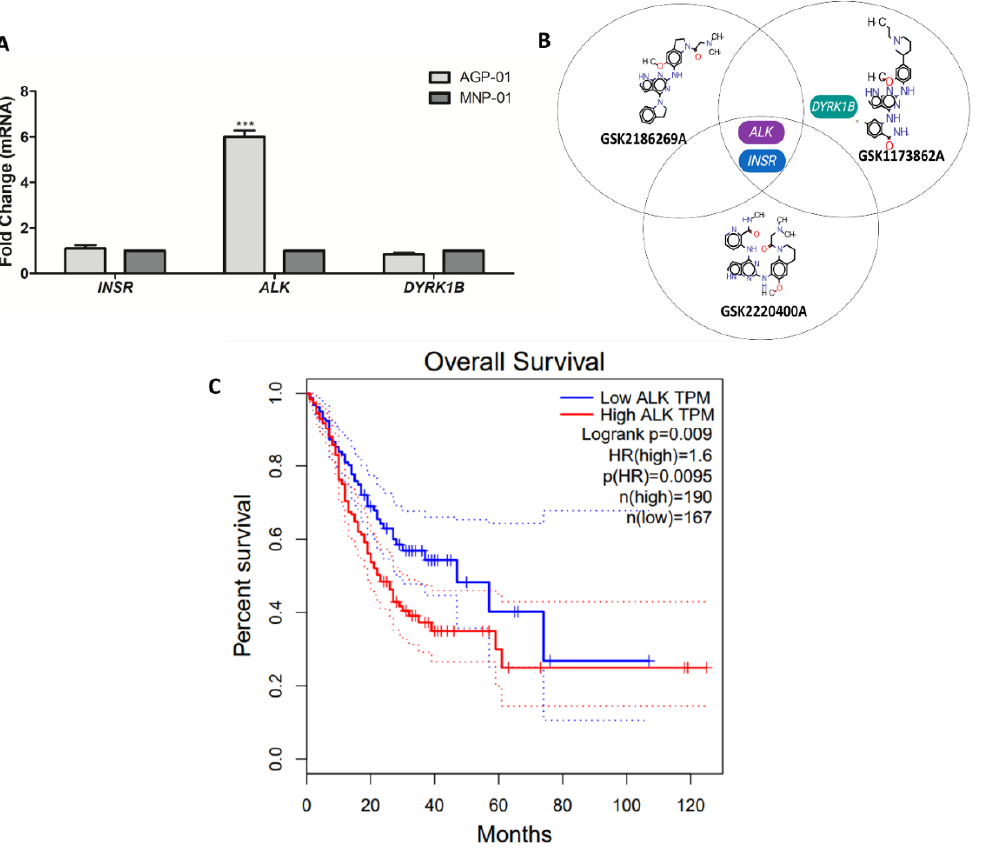
Figure 4. Overexpression of the ALK gene in the metastatic gastric cancer cells AGP-01. ( A ) Gene expression of the three-target kinase for the three selected inhibitors were assessed by RT-qPCR. The comparative expression between AGP-01 cells (metastatic gastric cancer cell) and MNP-01 cells (non-malignant gastric mucosa) are shown as mean ± standard deviation (SD). ( B ) Diagram showing the three molecules selected in this study and their targets. ( C ) GEPIA server analysis for ALK expression on Cancer Genome Atlas Stomach Adenocarcinoma (TCGA-STAD) comparing tumor samples and normal samples. Red and blue dotted lines represent high and low ALK expression, respectively. Significant differences compared to untreated control: *** p < 0.001.